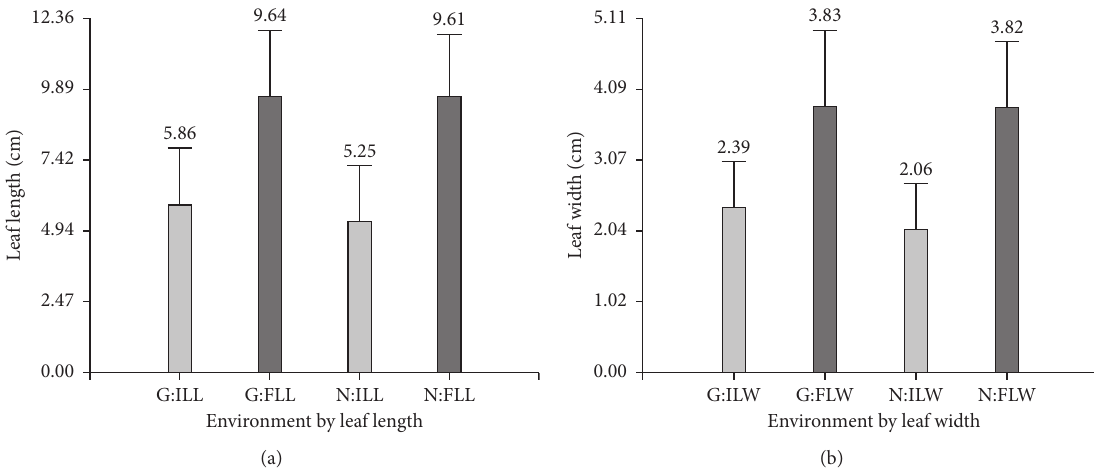
Figure 5: (a) Leaf length (cm) and (b) leaf width (cm) of coffee plants in nursery and greenhouse. G: greenhouse, N: nursery, ILL: initial leaf length, FLL: final leaf length, ILW: initial leaf width, and FLW: final leaf